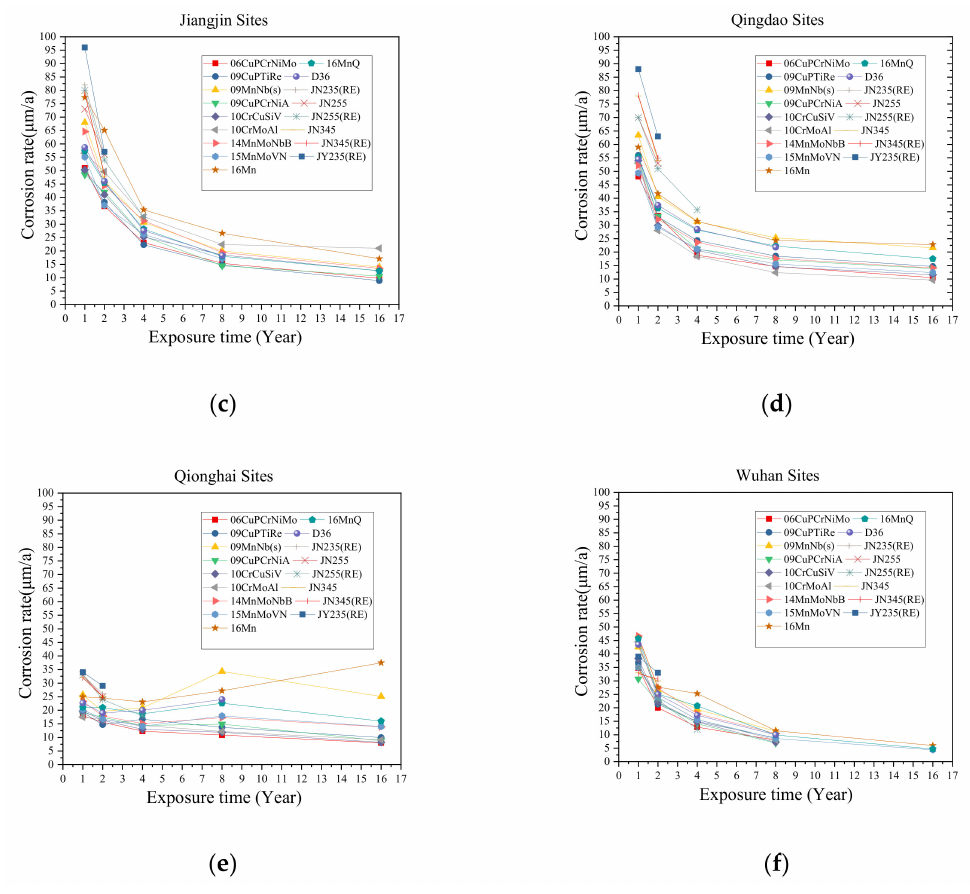
Figure 2. Corrosion rates of 17 LAS versus exposure time in different site: ( a ) Beiing, ( b ) Guangzhou, ( c ) Jiangjin, ( d ) Qingdao, ( e ) Qionghai, ( f )